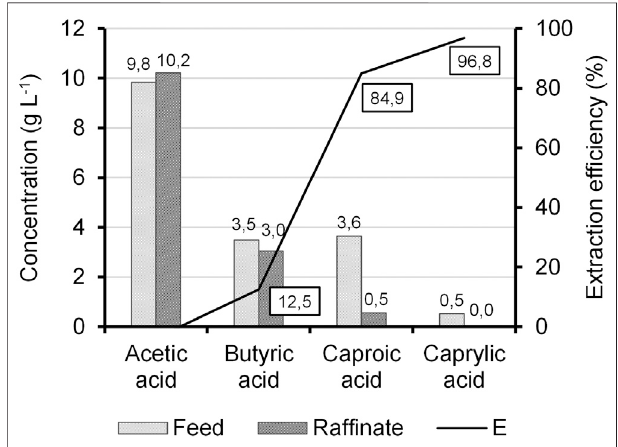
FIGURE 6 | Extraction ef fi ciency (E) and concentrations of different carboxylic acids in the feed and raf fi nate